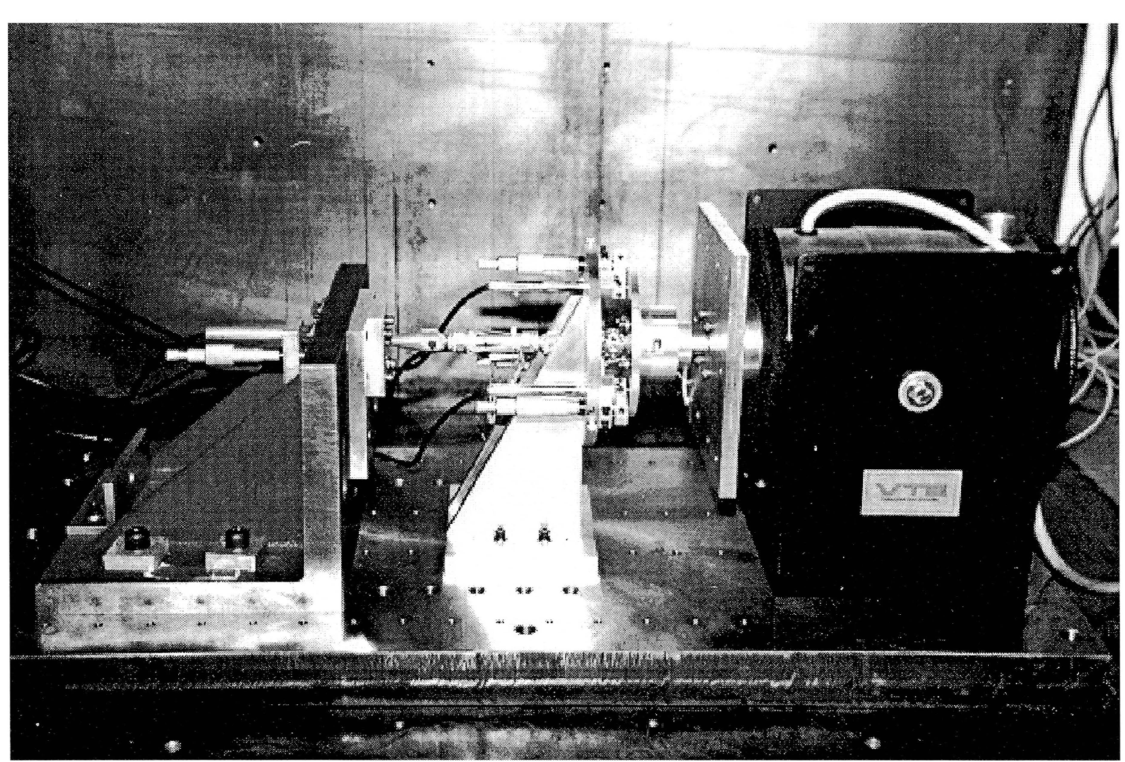
FIGURE 2 Photograph of the force-state map test